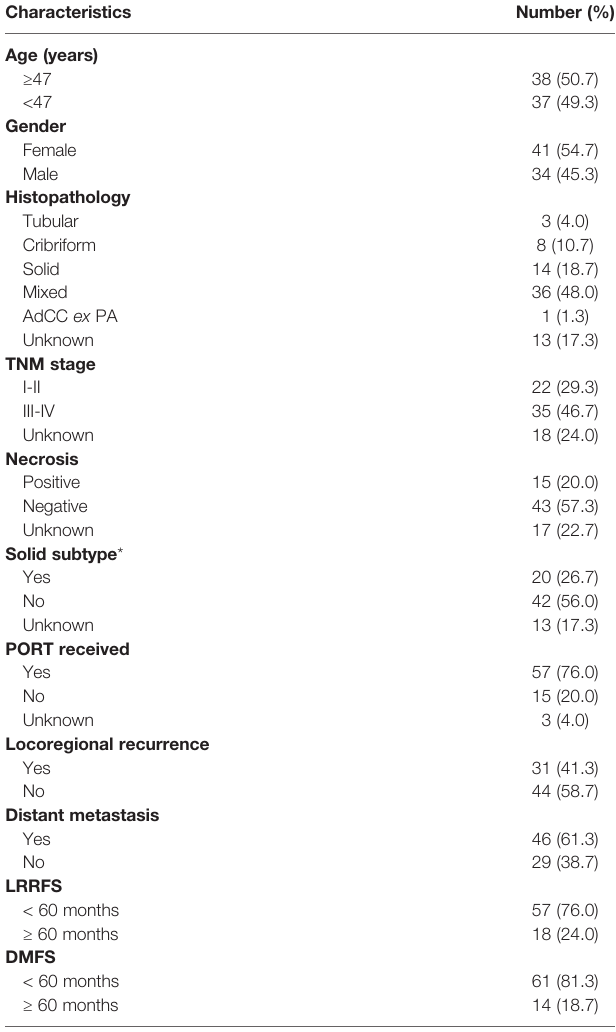
*Including presence of solid component. AdCC ex PA, adenoid cystic carcinoma ex pleomorphic adenoma; DMFS, distant metastasis-free survival; LRRFS, locoregional recurrence-free survival; TNM, tumor- nodes-metastases; PORT, postoperative